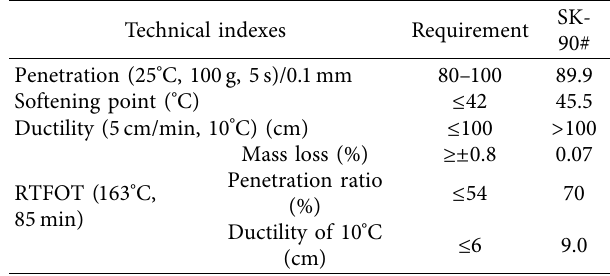
Table 1: Technical properties of SK-90#